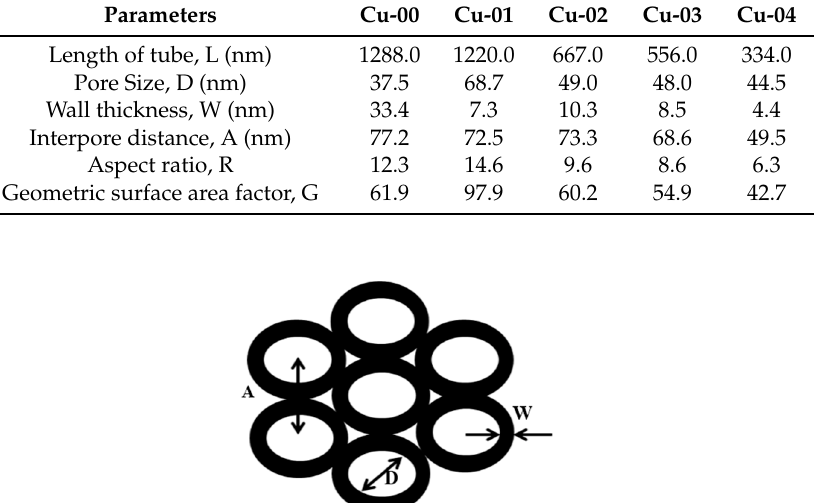
Figure 1. Scanning electron microscopy (SEM) images of TiO 2 NTs for ( a ) Cu ‐ 00; ( b ) Cu ‐ 01; ( c ) Cu ‐ 02; ( d ) Cu ‐ 03, and ( e ) Cu ‐ 04. Table 2. Geometrical dimension of all samples. Table 2. Geometrical dimension of all samples.